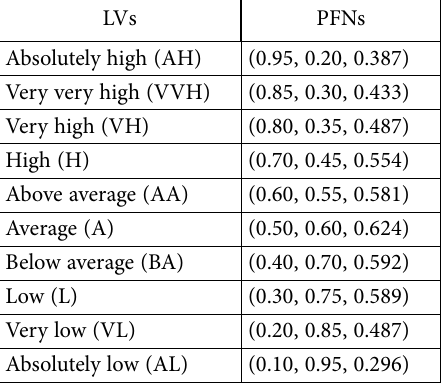
Table 3. LVs for the options and barriers